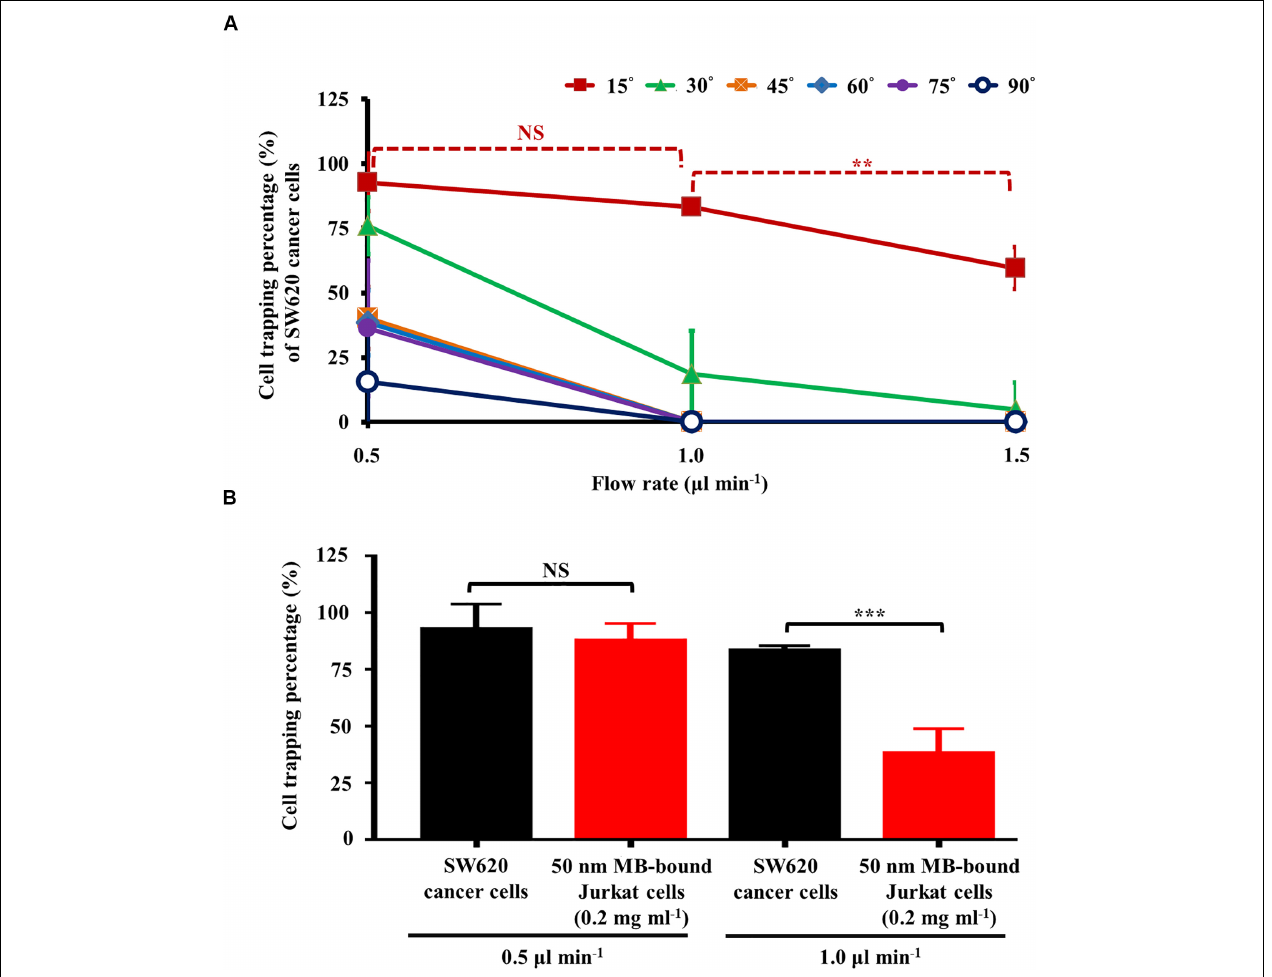
FIGURE 4 | (A) the cell trapping percentage (%) of SW620 cancer cells trapped at the rectangular light bar area under different flow rates (0.5, 1.0, and 1.5 µ l min − 1 ) and angles (i.e., the angle between the light bar image and the flow direction of the sample flow) (15 ◦ , 30 ◦ , 45 ◦ , 60 ◦ , 75 ◦ , and 90 ◦ ), and (B) comparison of cell trapping percentage (%) between SW620 cancer cells and 50 nm magnetic microbead (MB)-bound Jurkat cells (concentration: 0.2 mg ml − 1 ) under the selected flow rates (i.e., 0.5 and 1.0 µ l min − 1 , set angle: 15 ◦ ) [Data were presented as mean ± standard deviation ( n > 3). One-way ANOVA and the Tukey